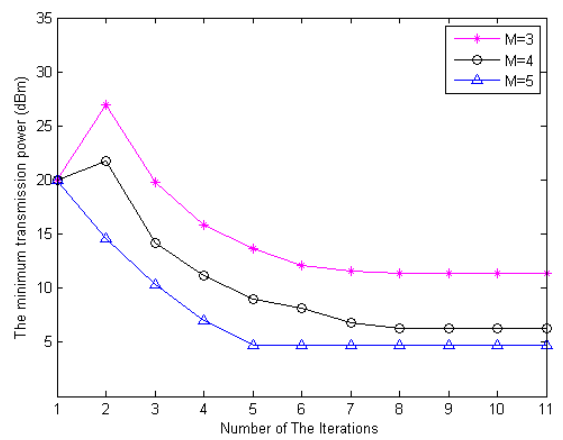
Figure 2. The minimum transmit power versus the number of iterations for the proposed algorithm